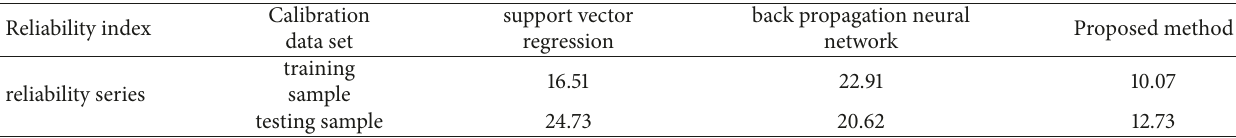
Table 2: SAPE of proposed method and referenced method for upper-phase model based on weekend data (%).